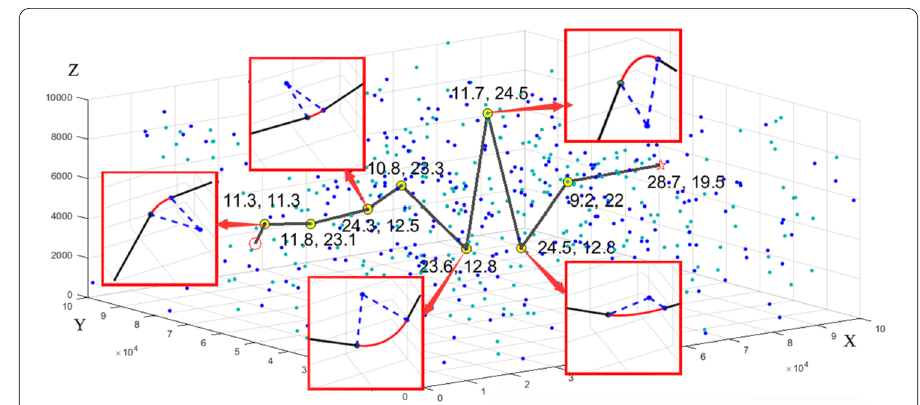
Figure 9 Spatial route planning representation in data set 1